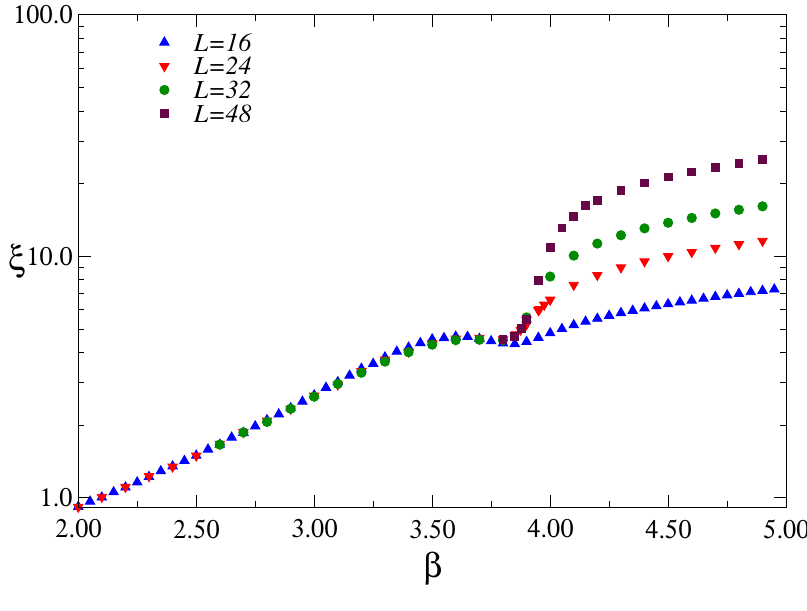
Figure 8 . Plot of ξ versus β for N c = 2 , N f = 4 , γ = 0 , and v = 1